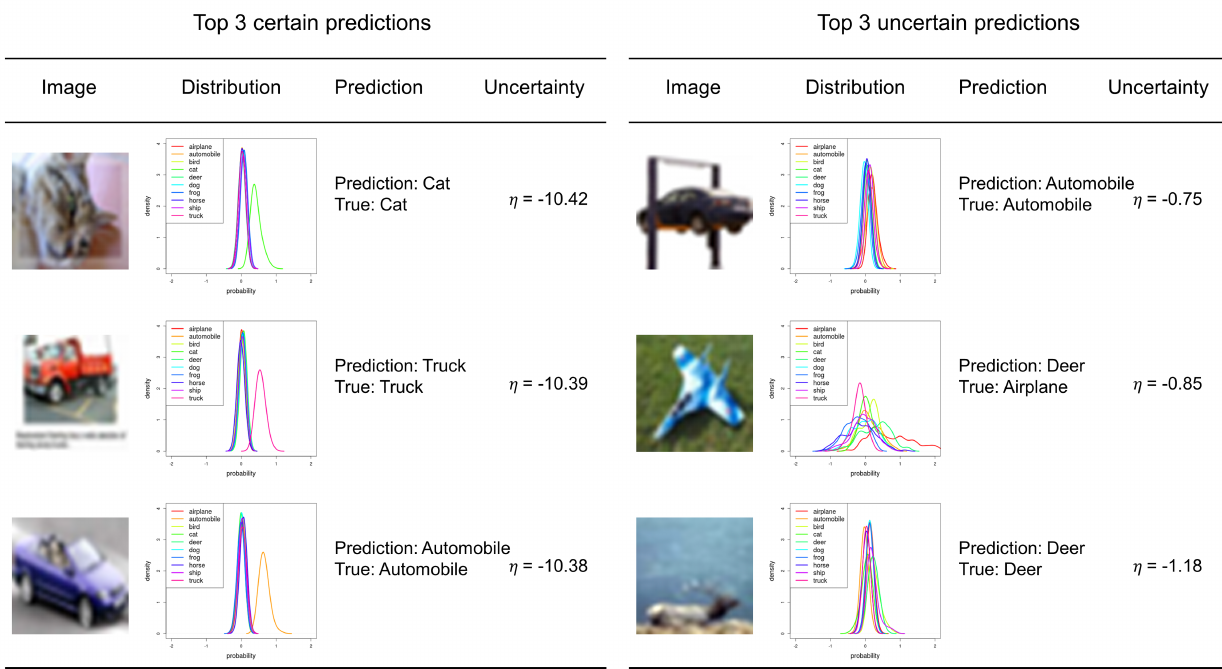
Figure 5. Certain predictions and uncertain predictions for the test set of CIFAR-10. Top 3 certain predictions by cGAN-UC ( left ). Top 3 uncertain predictions by cGAN-UC ( right ). The ’Distribution’ column corresponds to the form of prediction results of cGAN-UC; each color indicates the estimated distribution for each class. Notice that the prediction result in second row of the uncertain predictions is wrong, and the others are